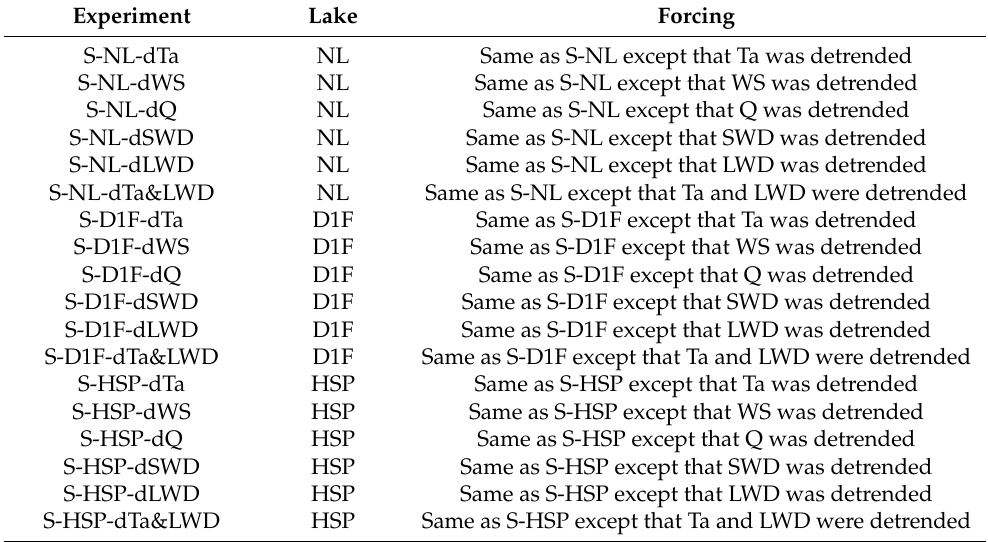
Table 2. S-(Lake)-d(meteorological variable) sensitivity